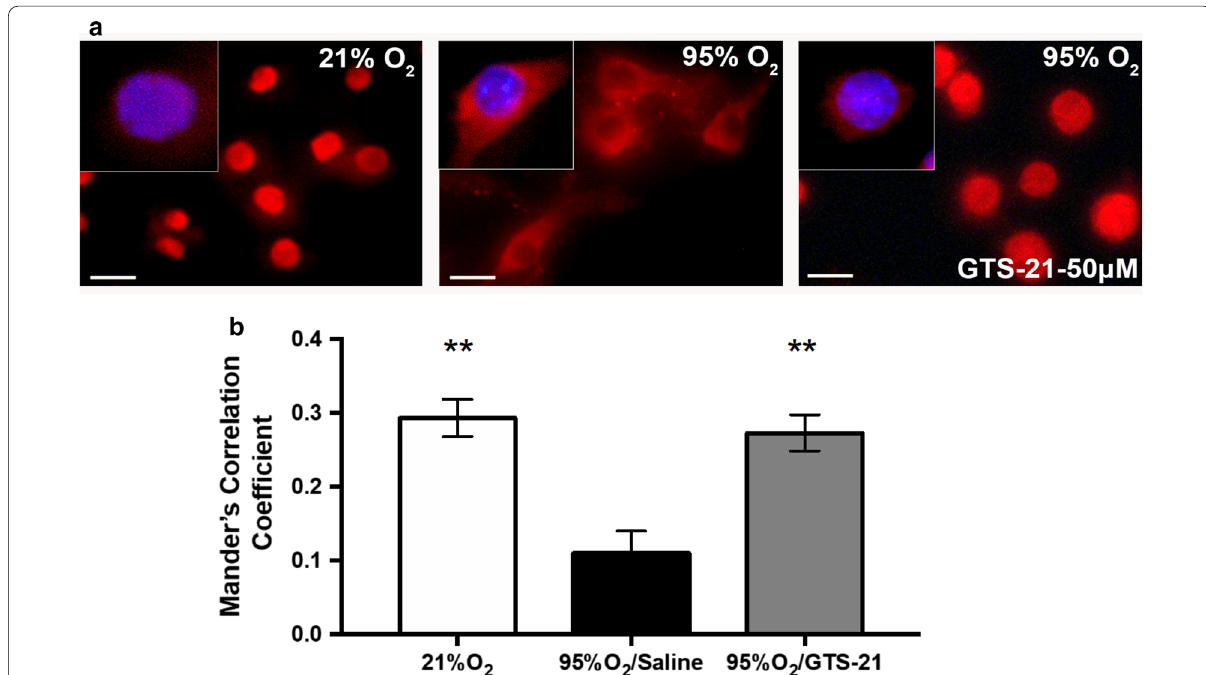
Fig. 4 GTS-21 inhibits cytoplasmic translocation of nuclear HMGB1 in macrophages. a RAW 264.7 cells were either exposed to 21% O 2 or 95% O 2 in the absence or presence of GTS-21 (50 µM) for 24 h. HMGB1 localization was visualized by immunofluorescence microscopy with anti-HMGB1 antibody (Red). Counterstaining with DAPI was used to visualize nuclei (Blue). Bar, 10 µm. Multiple pictures were taken using immunofluorescence microscope to visualize HMGB1. b Immunofluorescent micrographs were quantified by determining the amounts of HMGB1 colocalized into the nucleus using a Mander’s correlation coefficient. The immunofluorescence images shown are representative of three independent